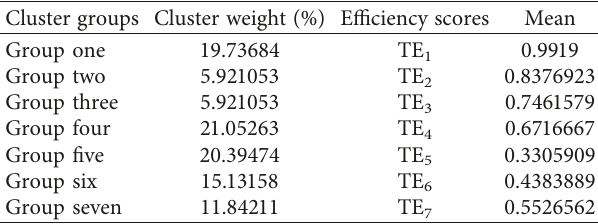
Table 4: Cluster-based technical efficiency. Cluster groups Cluster weight (%) Efficiency scores Group one